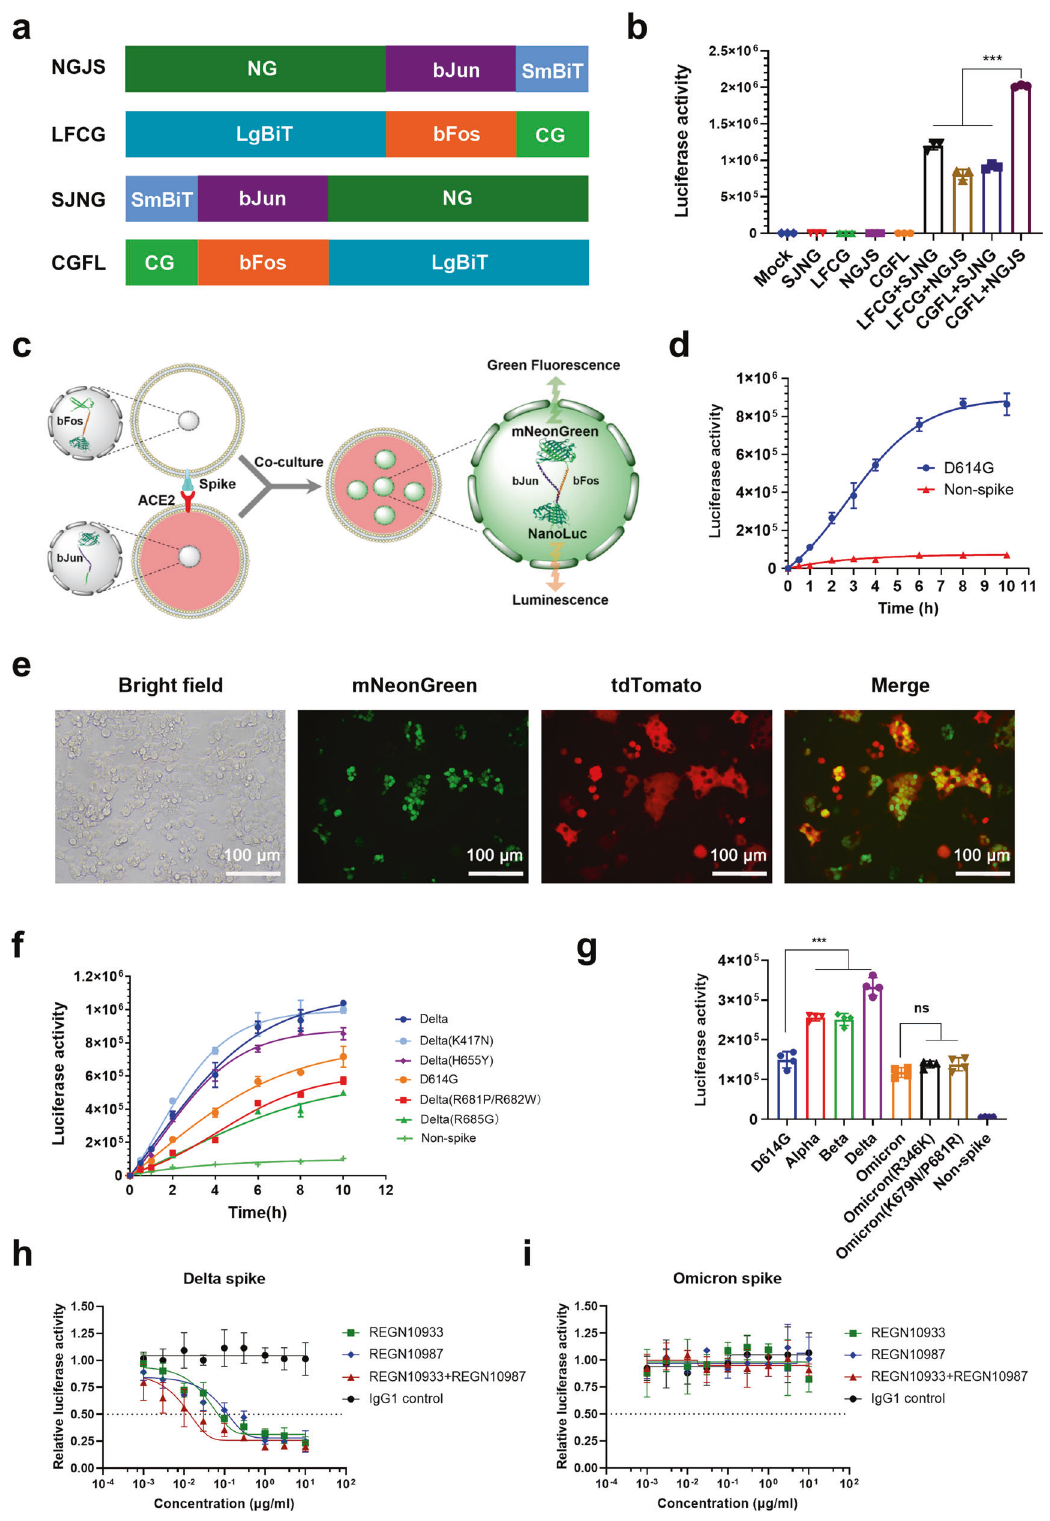
P681R) were constructed and the cell-fusion ef fi ciency of them were also compared. The results showed that the fusion ef fi ciency of these two Omicron spike mutations was improved than Omicron but not notable (Fig. 1g). All these spike proteins were expressed at comparable levels (supplementary Fig. 7).